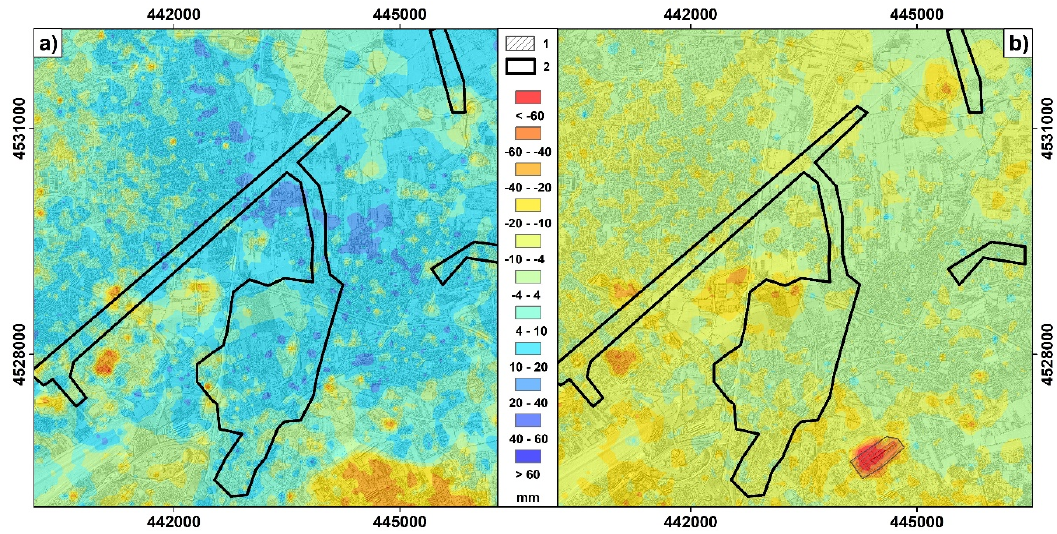
Figure 7. DInSAR-derived displacement maps: a ) ERS-1 / 2, 1992–2000 period; b ) ENVISAT, 2002–2006 period. Legend: 1) Agrifood Centre of Naples (CAAN); 2) wells field area. Table 2. DInSAR LoS measurements referred to the whole